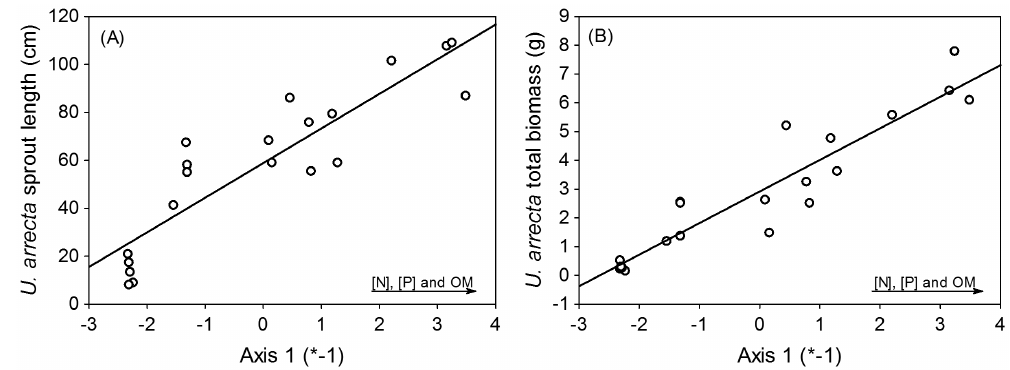
Figure 2. Relationship between U. arrecta ’s sprout length (A) and biomass (B; DW) with the principal component analysis Axis 1 (representing N, P and organic matter in the